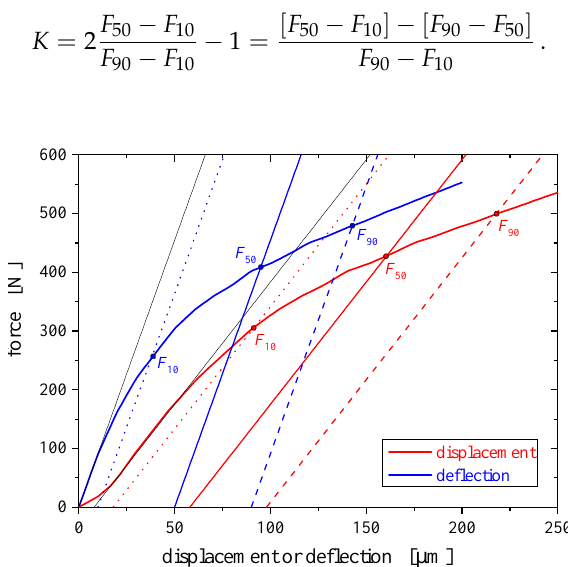
Figure 2. Force levels at 10, 50, 90 µ m offsets applied to force vs. displacement and deflection curves, respectively: (i) The initial settling due to imperfections in load transfer across interfaces leads to a positive initial curvature, and subsequently an inflection point. (ii) The frame compliance (if not corrected